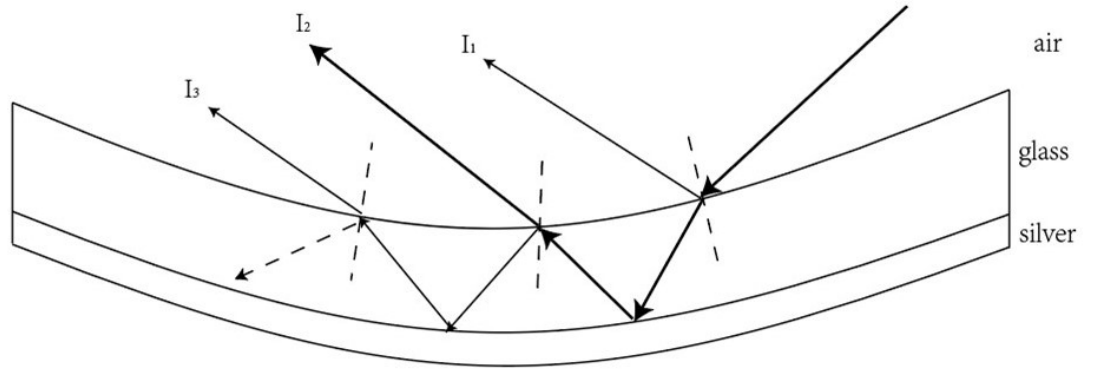
Figure 2. Composition of reflected